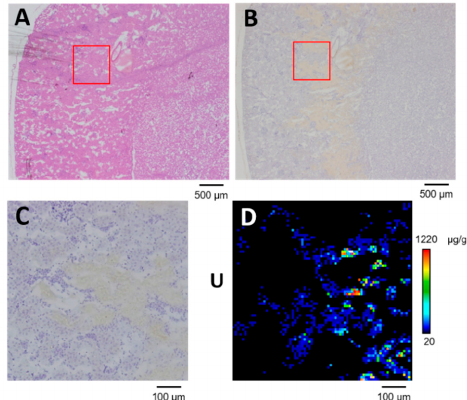
Figure 6. Uranium distribution in OSOM of kidney with scattered concentrated phosphorus on day 1 post-administration of UA (2 mg kg − 1 ). ( A ) Serial section stained with hematoxylin and eosin. ( B ) Serial section immunostained for glutamine synthetase. ( C ) High-resolution image of boxed area in ( A ) and ( B ). ( D ) Uranium imaging (75 × 75 steps at 10 µ m per step; beam size, 1 µ m × 1 µ m). The periphery of the renal cortex is on the left side of all images.